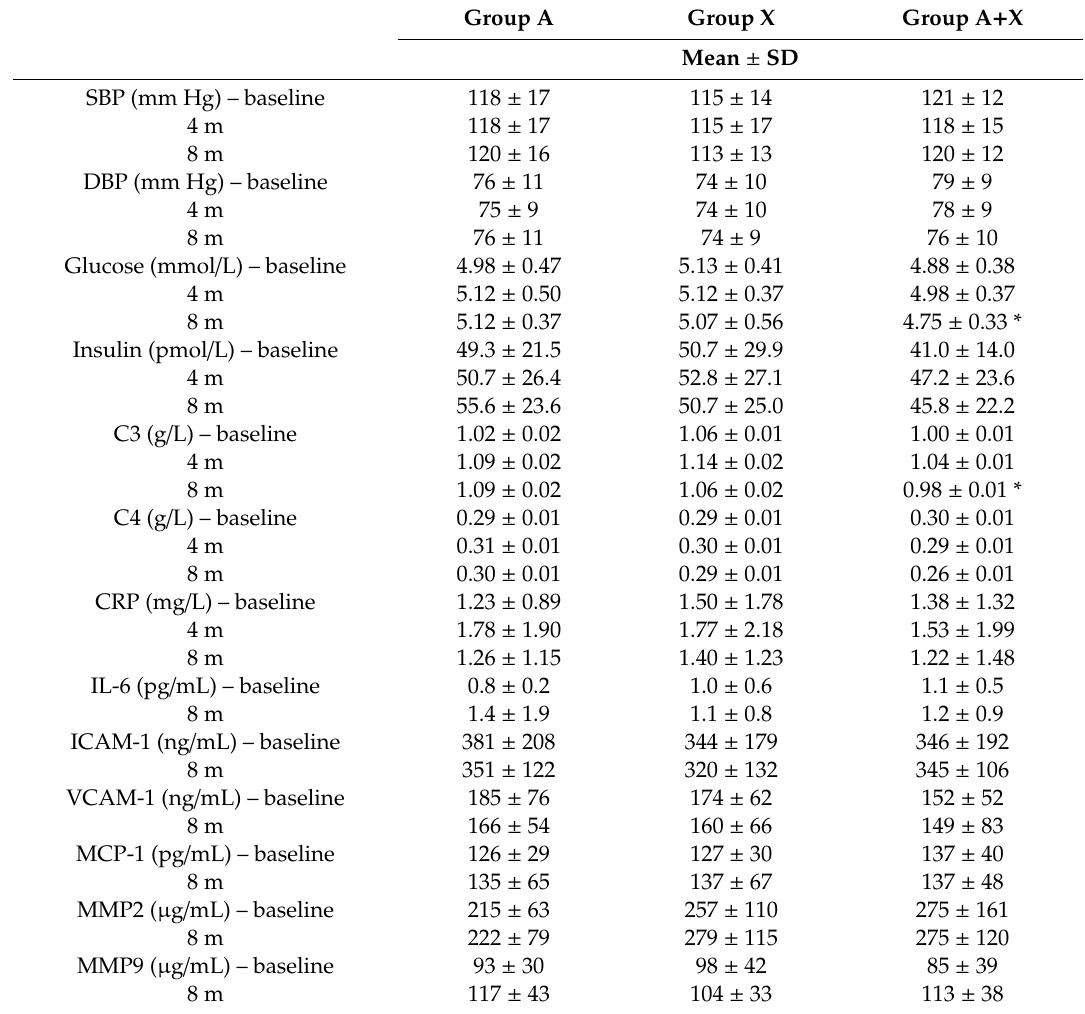
Table 3. Cardiometabolic and inflammation parameters for the three groups at the di ff erent time points (mean ±